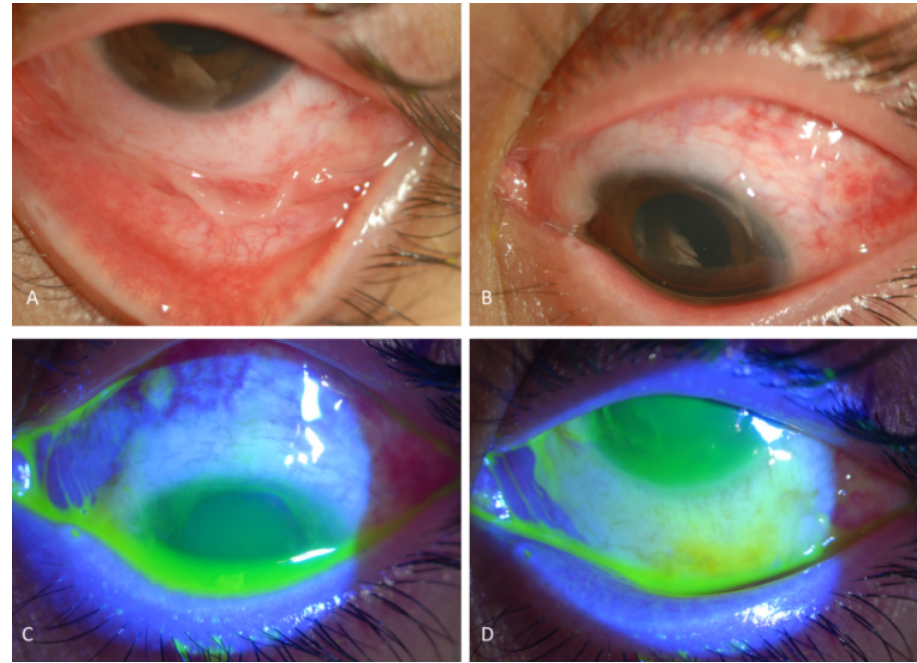
Figure 1: Total corneal and 75% conjunctival epithelial loss and limbal ischemia for nine clock hours, two weeks after the chemical